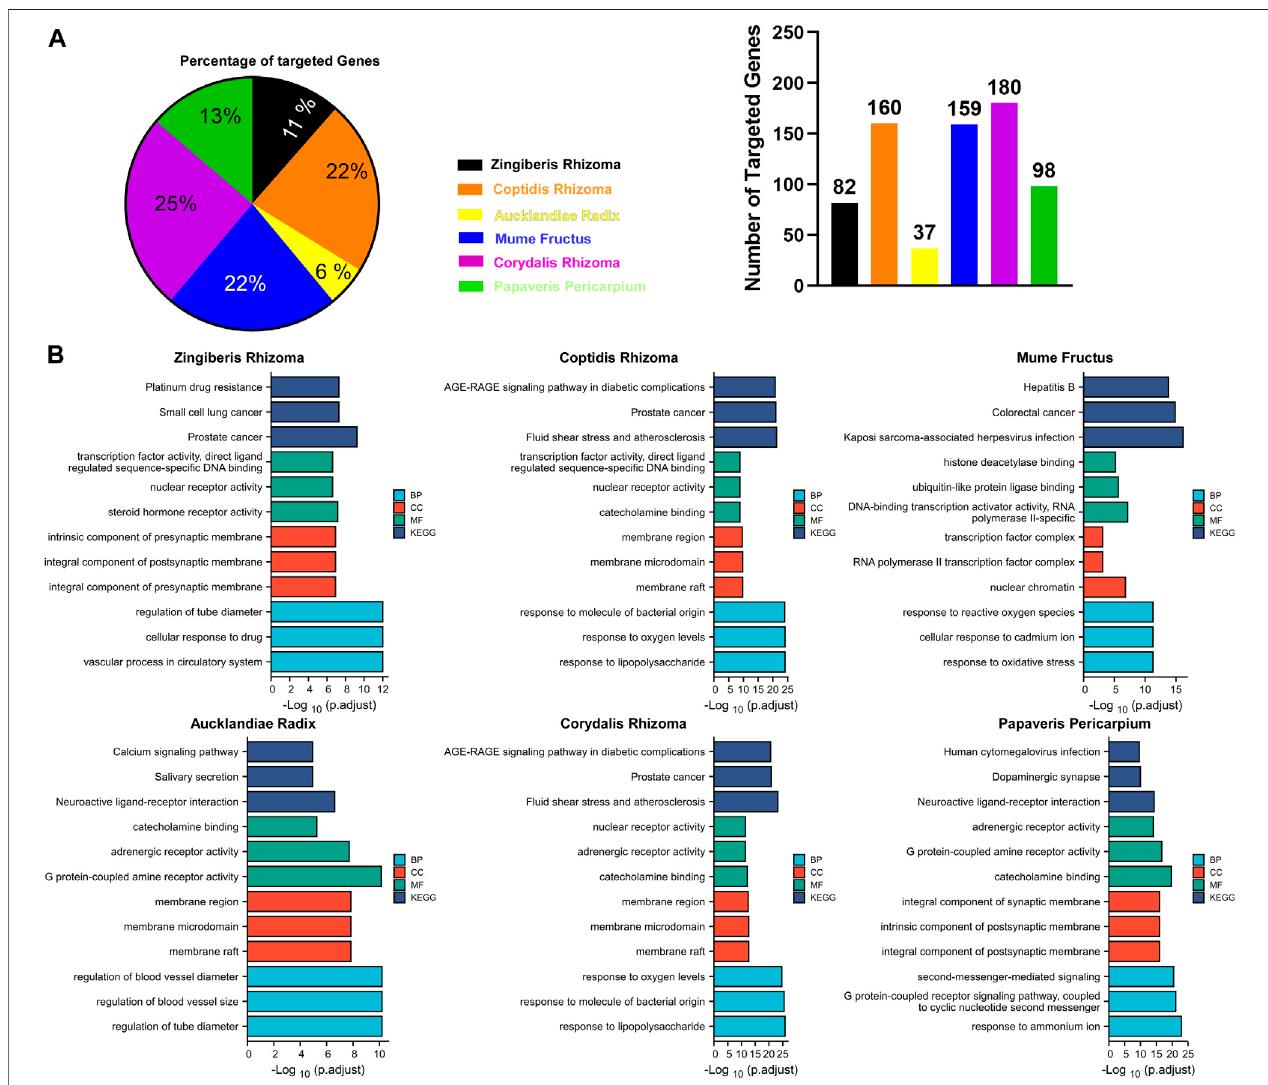
FIGURE3 | The functionofeach herb in the pathogenesisof UC. Pie chart illustrating the target genesof each herb in UC (A) ; GO and KEGG analysisshowing the enrichment of herb-target genes (B) .